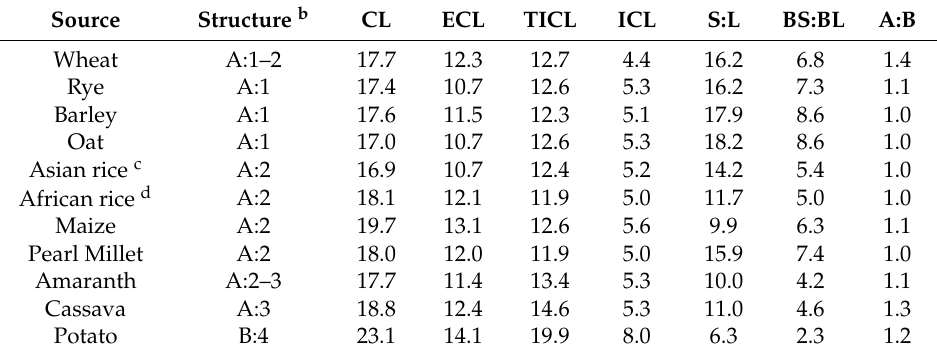
Figure 2. Unit chain profile of rice amylopectin ( a ) and its internal chain profile as obtained from the ϕ , β -limit dextrin ( b ), which possesses type 2 structure. Different chain categories are indicated. The A-chains (maltose peak) in ( b ) are actually external chain stubs and each B-chain carries a glucose residue as an external chain stub. Table 2. Chain lengths and chain ratios in amylopectins a .